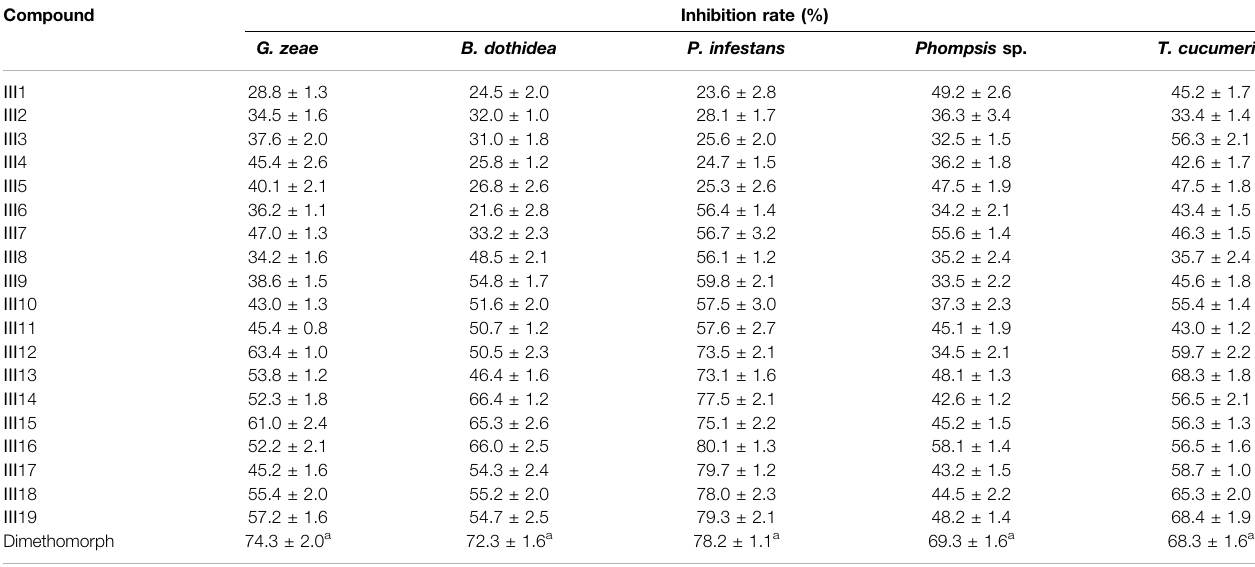
TABLE 2 | Antifungal activity of compounds Ⅲ 1 – Ⅲ 19 in vitro (50 μ g/ml). Compound